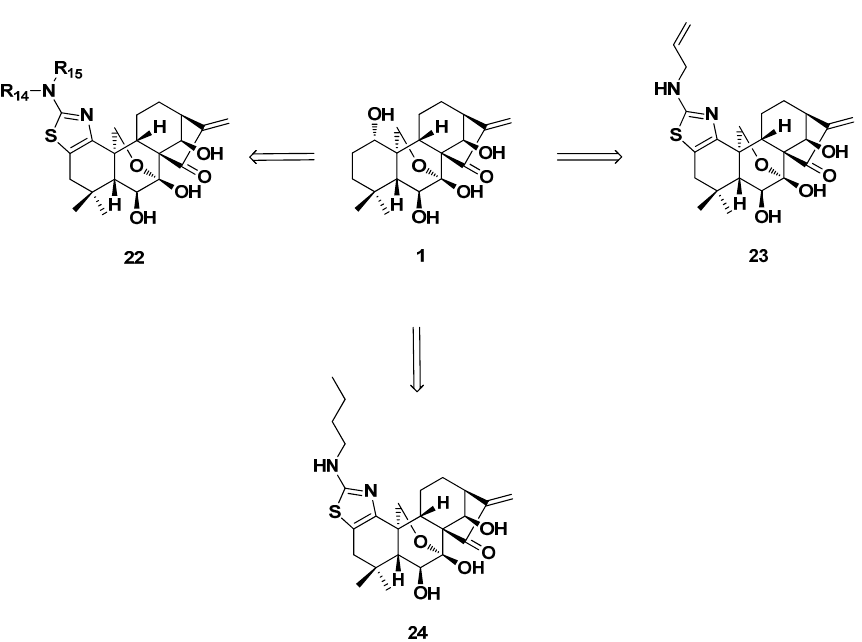
Figure 11. The thiazole-fused A-ring modified oridonin derivatives ( 22 – 24 ).